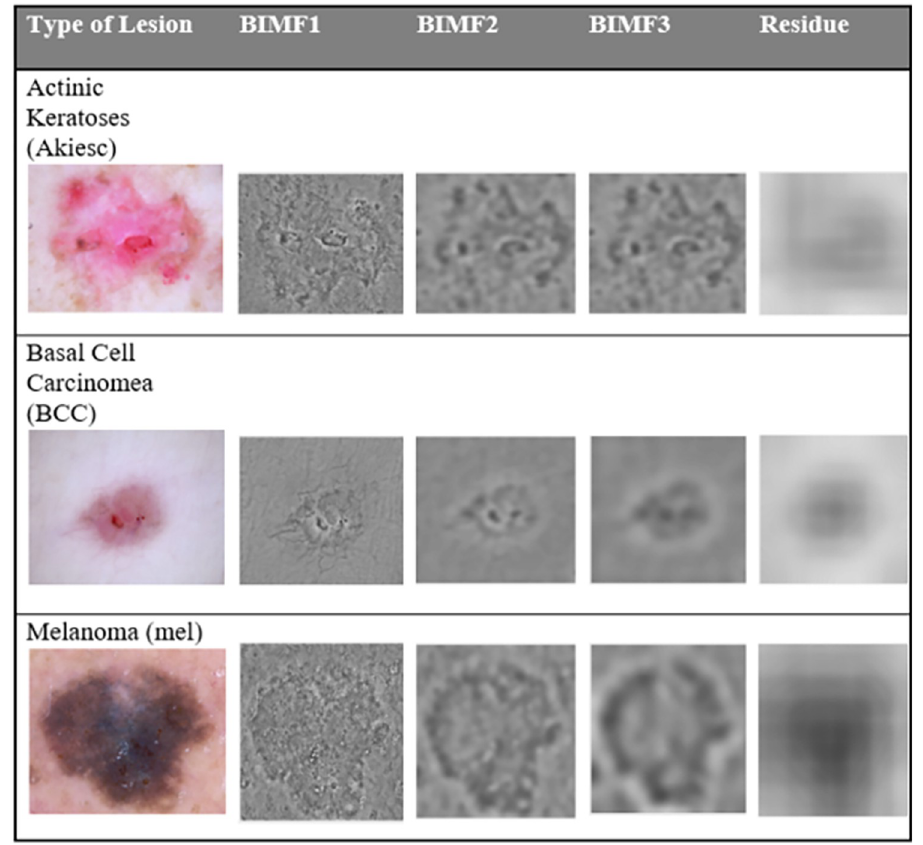
Fig 4. The decomposed skin lesion using MREMD.